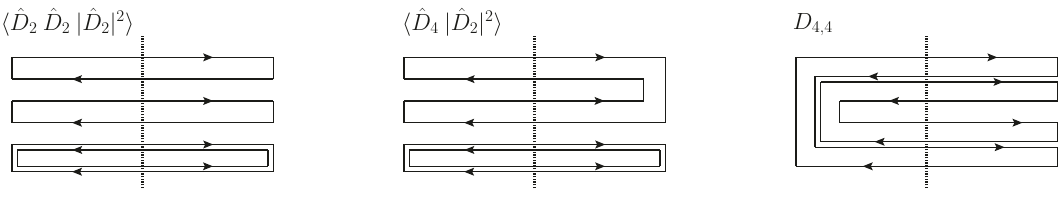
^ D ^ D ^ D ^ D ^ D 2 2 , and D 4 ; 4 contributing to 2 2 j 2 j 4 j 2 j h i h i